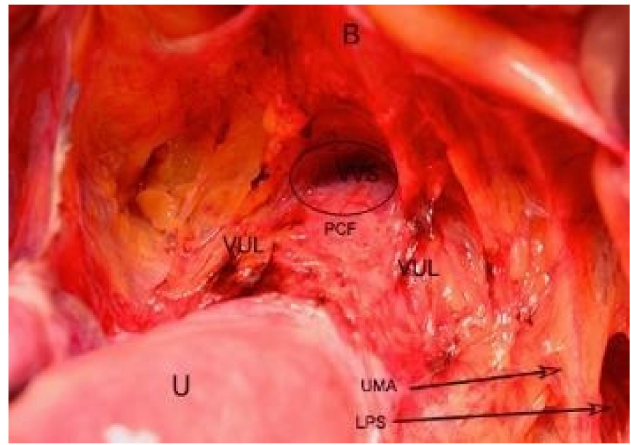
Figure 11. Vesicovaginal space dissected by open surgery. B—bladder; U—uterus; UMA—umbilical artery; LPS—lateral paravesical space; VUL—cranial portion of the vesico-uterine ligament; PCF— pubocervical fascia; VVS—vesicovaginal